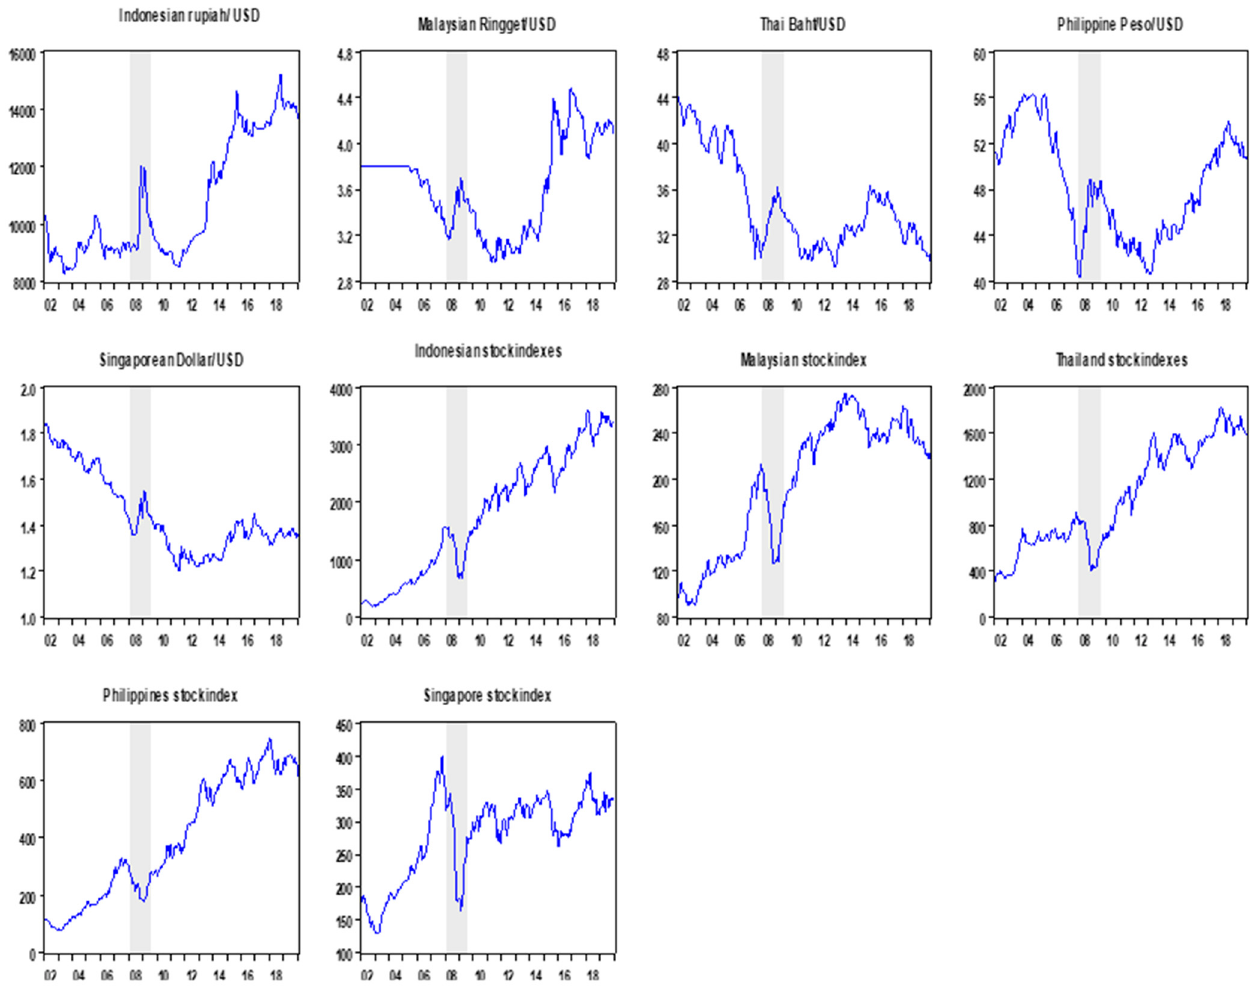
Figure 1. Exchange rate and stock indexes of the ASEAN-5 region .